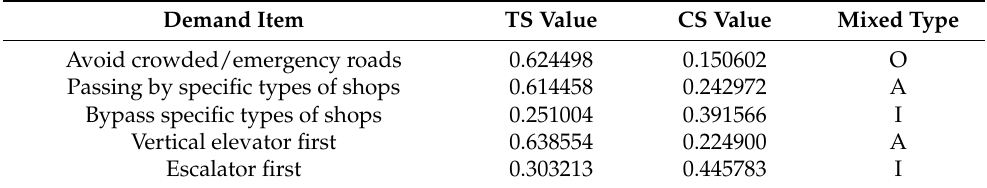
Table 11. Mixed analysis of indoor navigation demand factors in shopping malls.